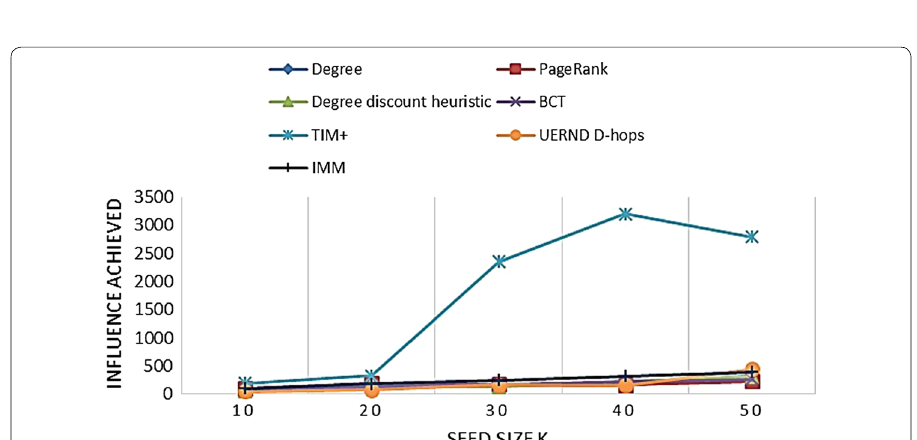
Fig. 4 Influence coverage under LT model on netphy data. Degree PageRank Degree discount heuristic BCT TIM UERND D-hops IMM +